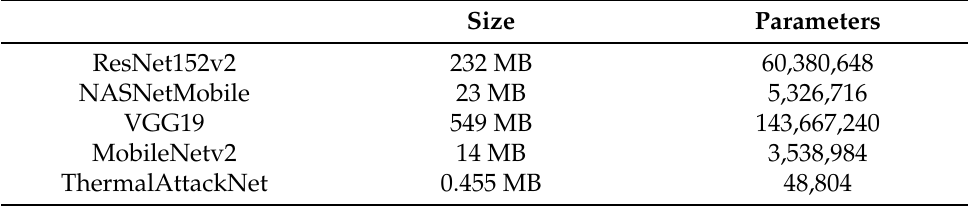
Table 1. Comparison between models based on disk size and parameters.